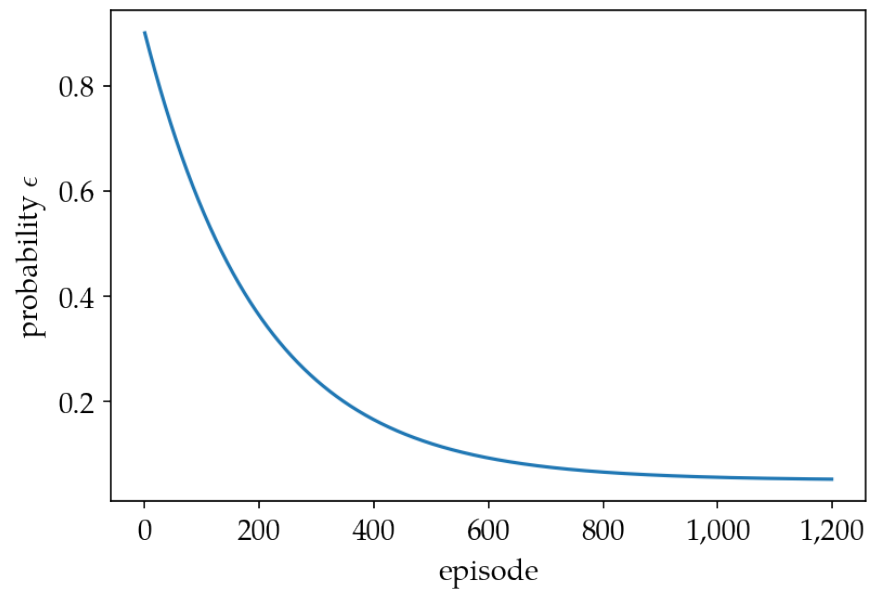
Figure 7. Plot of random probability for (cid:101) -greedy policy during training. Episode Duration